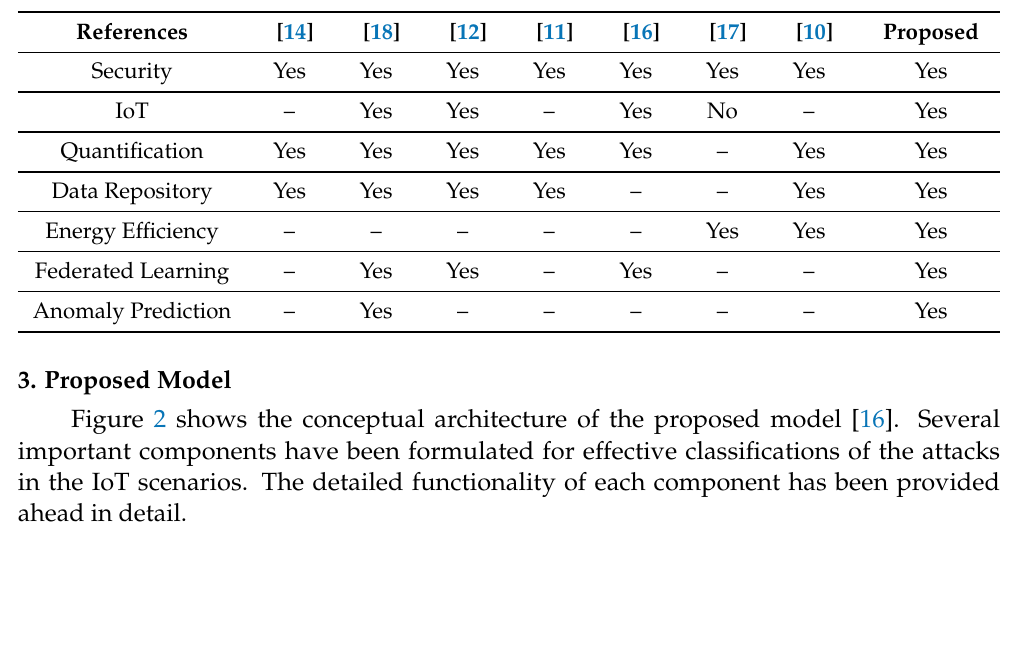
Table 1. State-of-the-art Comparison (Yes: Available, –: Not